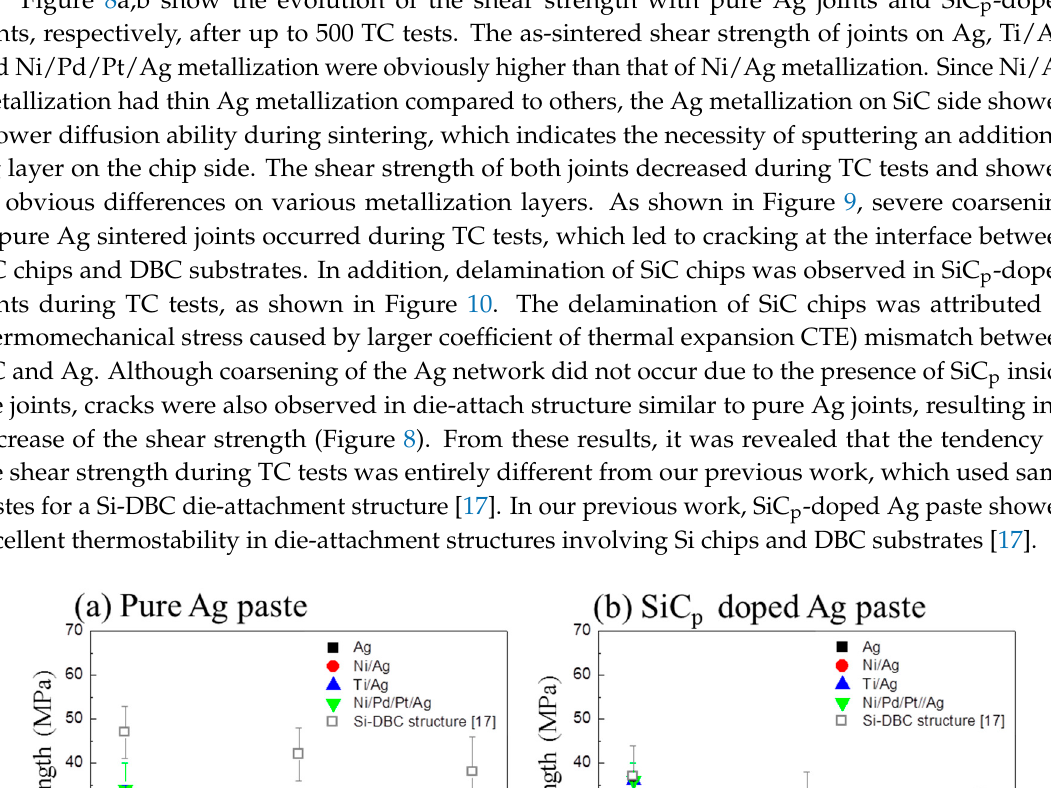
Figure 7. Evolution of the on-resistance of ( a ) pure Ag paste and ( b ) SiC p -doped Ag paste on various substrates.